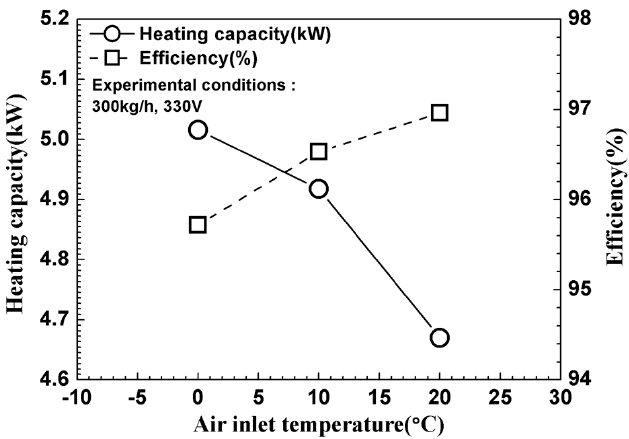
Figure 5. Variation of heating capacity and efficiency.